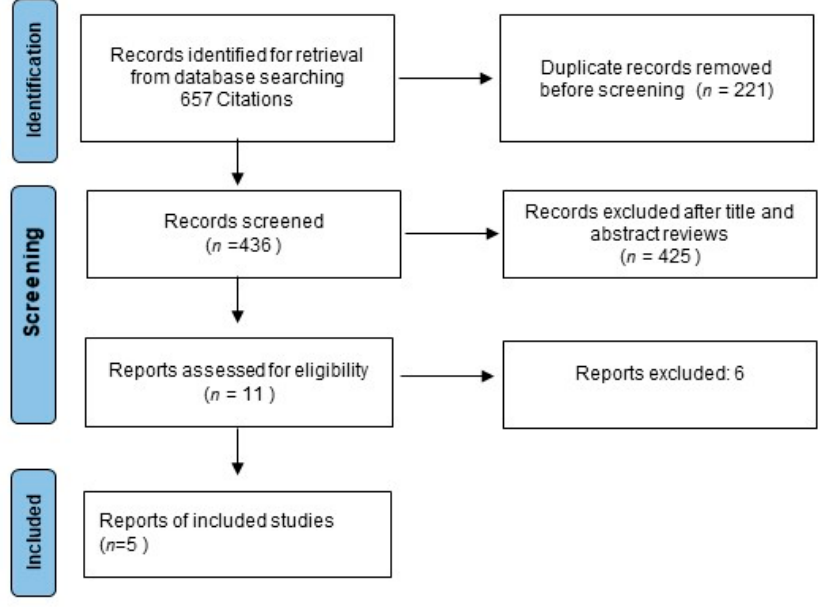
Figure 1. Study flow chart.